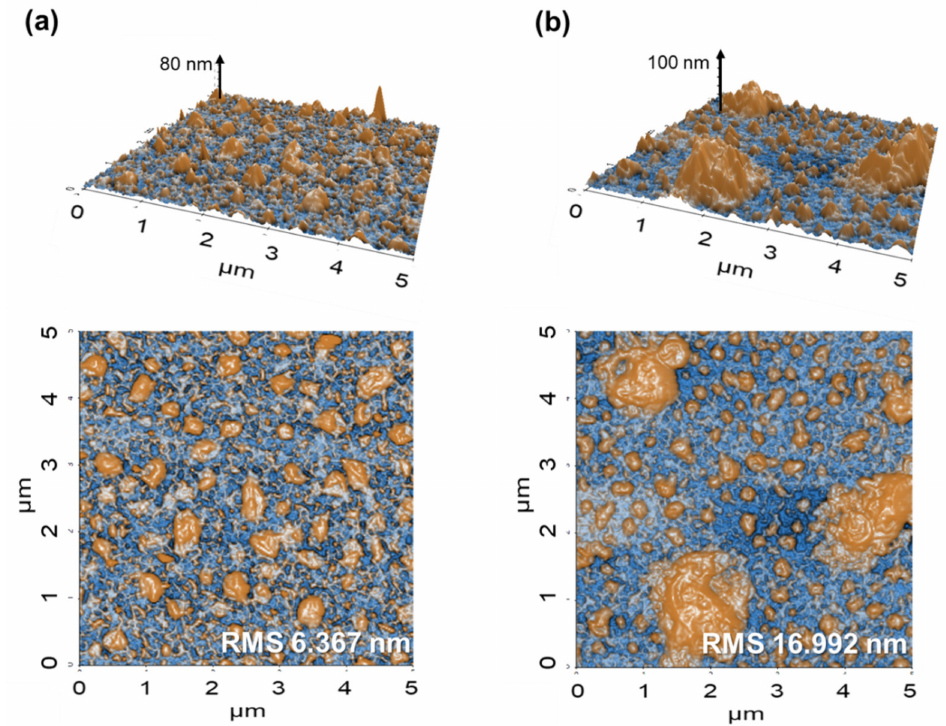
Figure 2. Atomic force microscopy (AFM) images of ( a ) A-ZnO on SLG, and ( b ) sputtered i-ZnO on